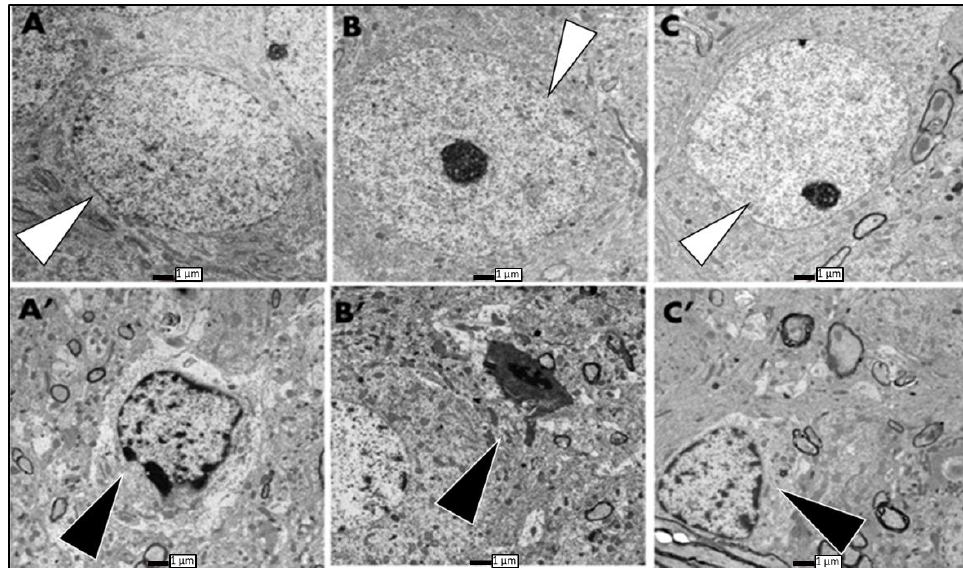
Figure 6. Electron micrographs showing degeneration in different areas of the hippocampus of ADX rats compared to the SHAM operated; these were taken seven days postoperatively. ( A ) intact granule cell with well-defined nucleus and cell membrane of SHAM rats (white arrows). ( A ′ ) degenerated granule cell of the dentate gyrus with condensed chromatin, and irregular cell and nuclear membrane in ADX rats (black arrow). ( B , C ) show healthy pyramidal cells of CA4 and CA3, respectively, in SHAM rats (white arrows). ( B ′ ) showing ultrastructure of CA4 dead neurons in ADX rats with disintegration of the cell body, condensation of the chromatin, and reduction of the nucleus volume (black arrow). ( C ′ ) degenerated pyramidal neurons of the CA3 in ADX rats showing irregular nucleus membrane and chromatin condensation (black arrow). Scale bar = 1 µm. Three independent sections per brain were examined (n = 3 in each group).